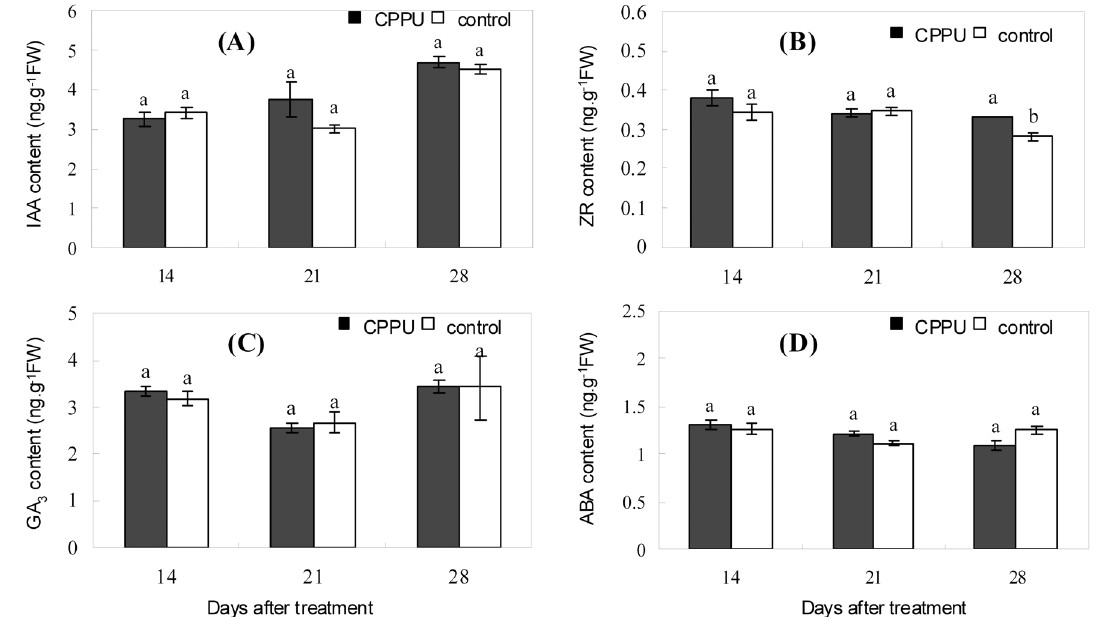
Fig 6. Effect of fruit raceme soaking with CPPU on the endogenous hormones in the seed. Different letters indicate significant difference between the treatment and the control based on t -test ( p < 0.05).